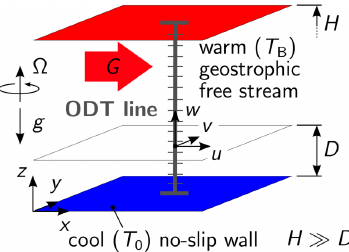
Figure 1. Sketch of the stratified Ekman flow configuration inves- tigated with application of the ODT model. A warm (temperature T B ) geostrophic bulk flow G resides over a rigid surface relative to a corotating frame of reference. The vectors of the angular velocity (cid:127) and gravity g are parallel. A sudden drop of the surface temper- ature from T B to T 0 at t = 0 is used to prescribe stratification to the Boussinesq fluid due to which the statistically stationary Ekman flow becomes transient. The height H of the columnar ODT do- main reaches up into the geostrophic free stream so that the Ekman boundary layer thickness fulfills D (cid:28) H and thus acts as reservoir for heat and momentum so that the flow evolves under almost con- stant bulk–surface temperature difference (cid:49)T = T B − T 0 >